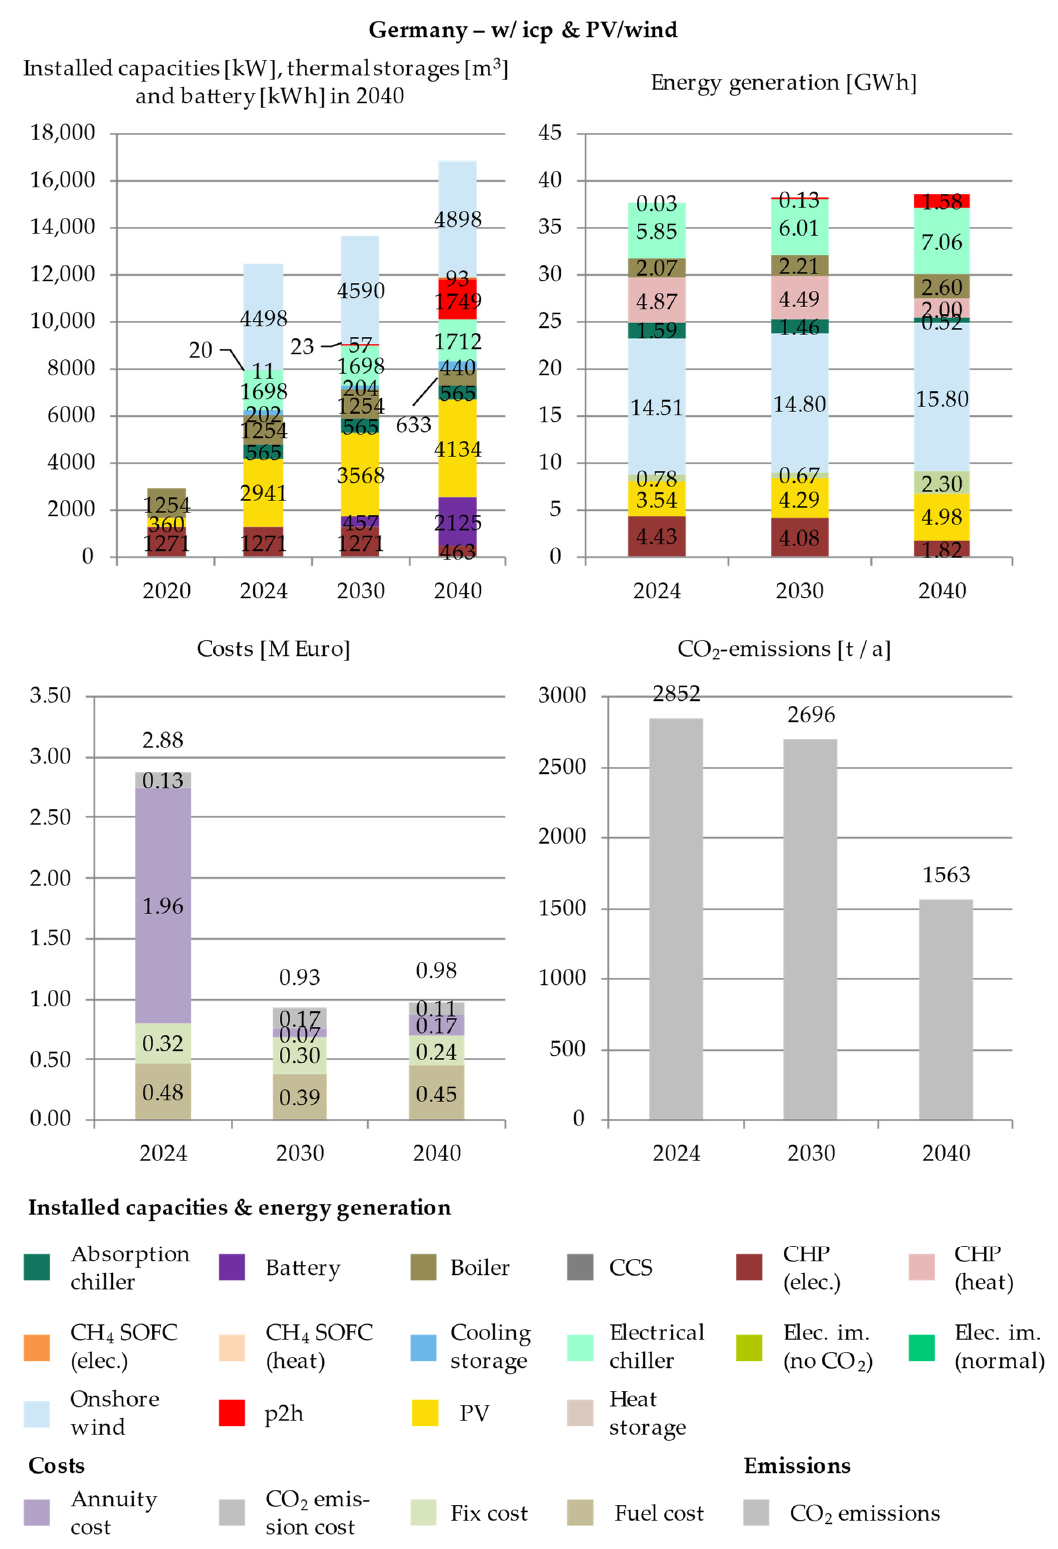
Figure A4. Detailed results for the German “w/ICP and PV/wind” scenario.